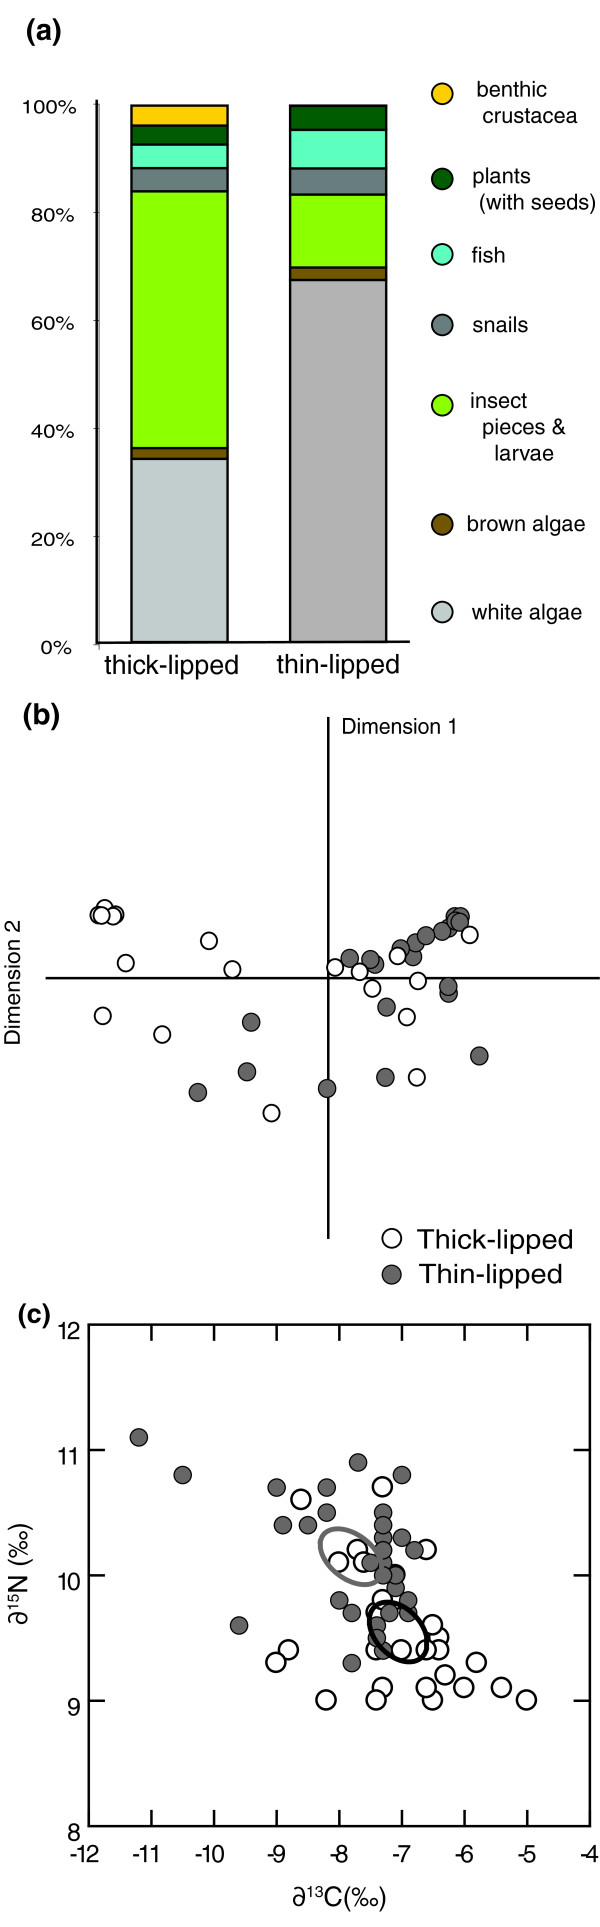
Thick-lipped and thin-lipped Midas cichlids in Apoyeque differ quantitatively in diet and trophic niche. (a) The proportion of gut contents per food category differs between thick- (n = 19) and thin-lipped (n = 22) fishes. (b) Multi-dimensional gut contents by morph displayed along the two primary axes. (c) Individual-level stable isotope values of δ13C and δ15N from thick-lipped (n = 29) and thin-lipped (n = 31) Apoyeque cichlids, with 95% confidence ellipses around the centroids.